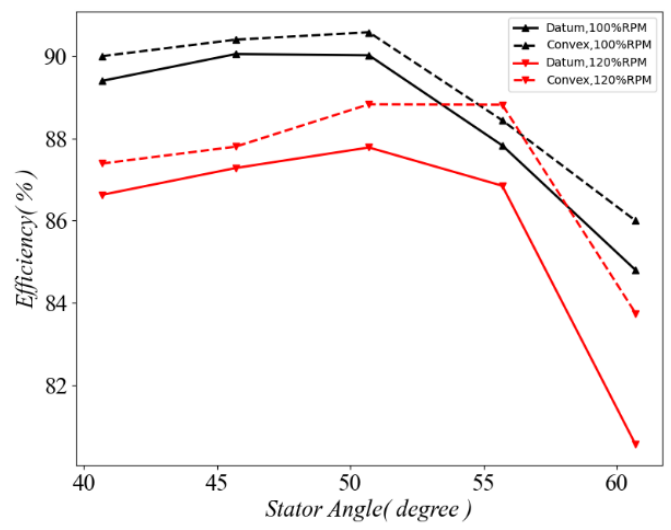
Figure 9. Efficiency versus the angle with different rotation speed, at designed pressure ratio.